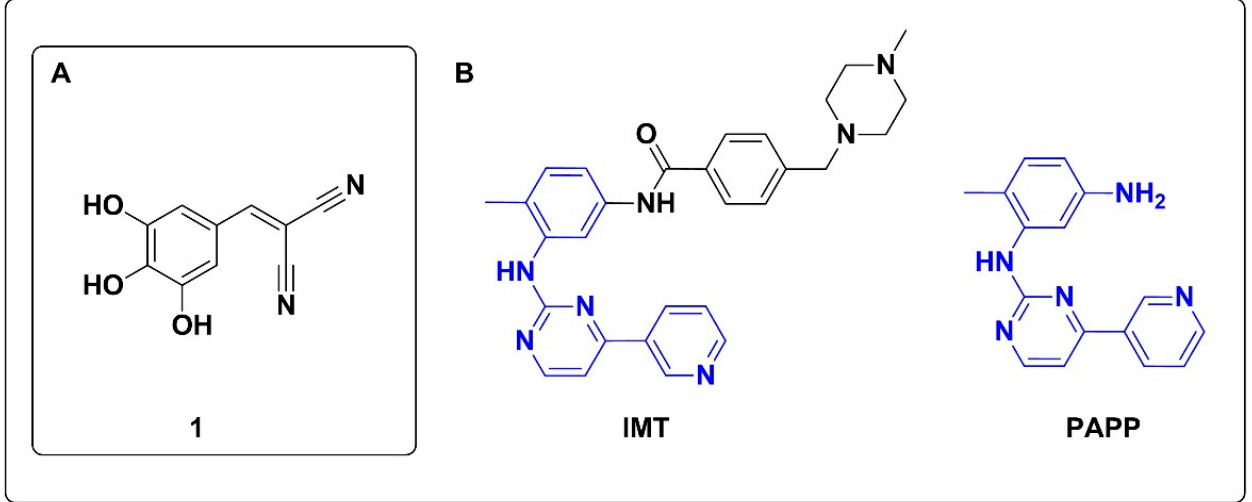
Figure 1. ( A ) Chemical structure of the TKI tyrphostin ( 1 ). ( B ) Chemical structure of the drug IMT and the PAPP skeleton.